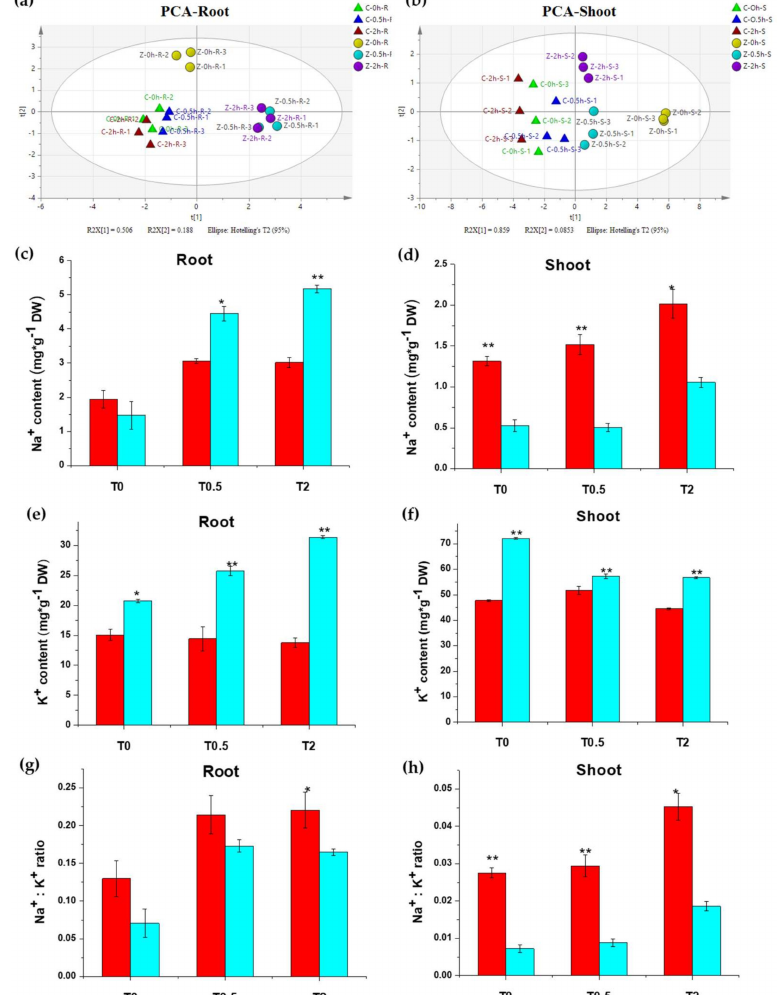
Figure 2. Metal ion contents in Chang7-2 and Zheng58 after salt treatment for 0.5 h and 2 h. Principal Component Analysis (PCA) score plot for root ( a ) and shoot ( b ); Na + content ( c , d ); K + content ( e , f ); and Na + / K + ratio ( g , h ) for root and shoot. * indicates significant di ff erence at 0.05; ** indicates a di ff erence at the 0.01 level determined by Student’s t -test. Red, Chang7-2; Light green,